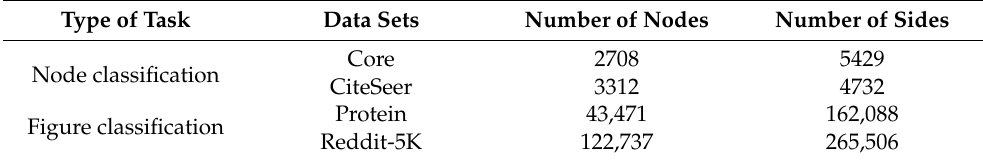
Figure classification